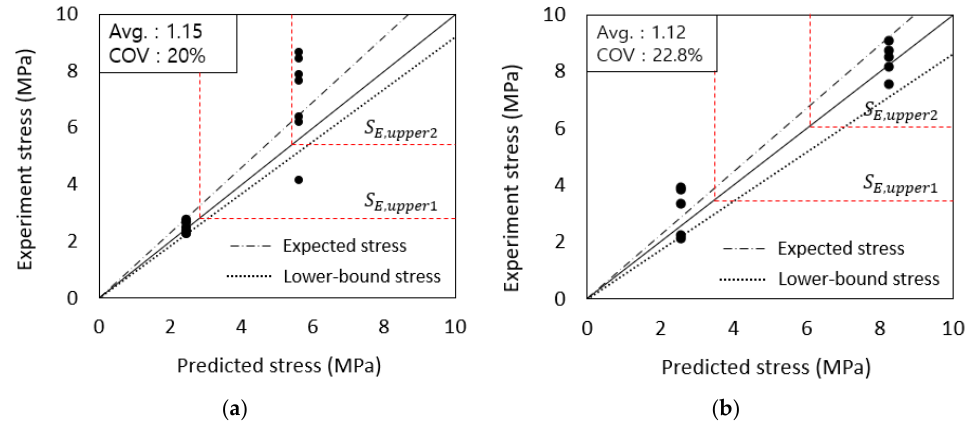
Figure 18. Predicted and test diagonal tension strengths: ( a ) Red clay brick masonry; ( b ) concrete brick masonry.